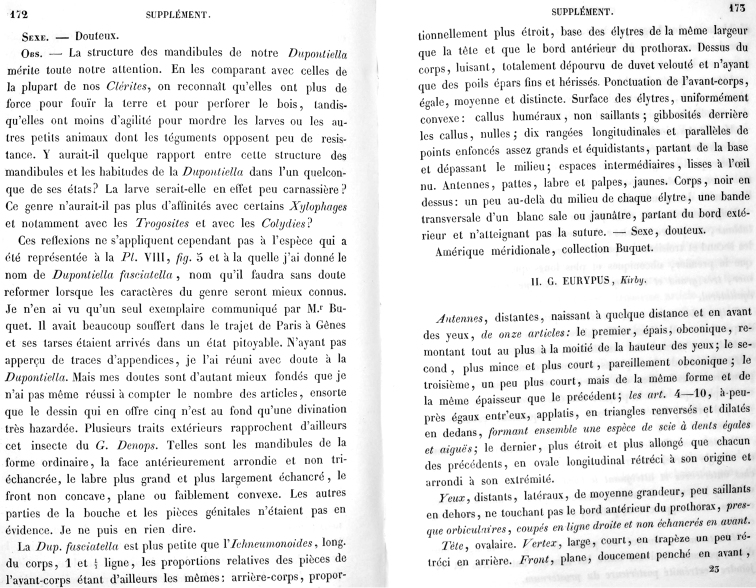
A facsimile of Spinola 1844: 172–173. The original descriptions of the species Dupontiella ichneumonoides and Dupontiella fasciatella.